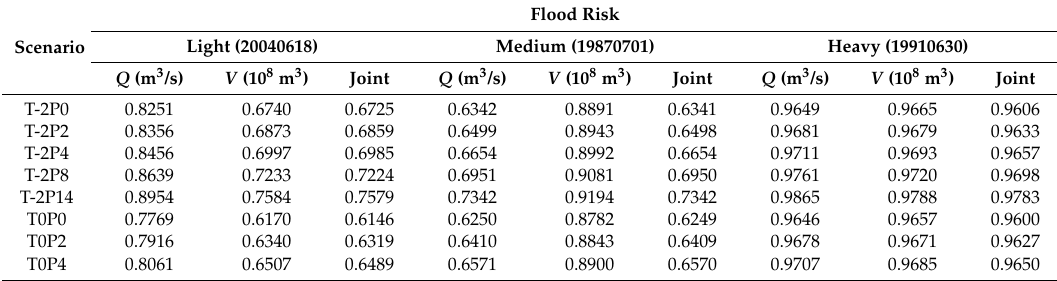
Table 9. The watershed flood risk under different climate